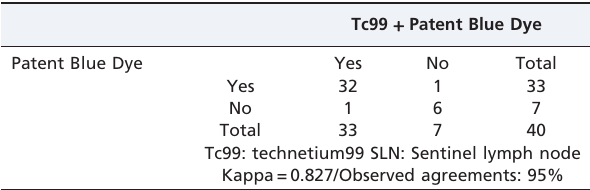
Table 1 - Kappa coefficient of concordance when comparing isolated patent blue dye with a combination of Tc99 and patent blue dye in SLN identification.